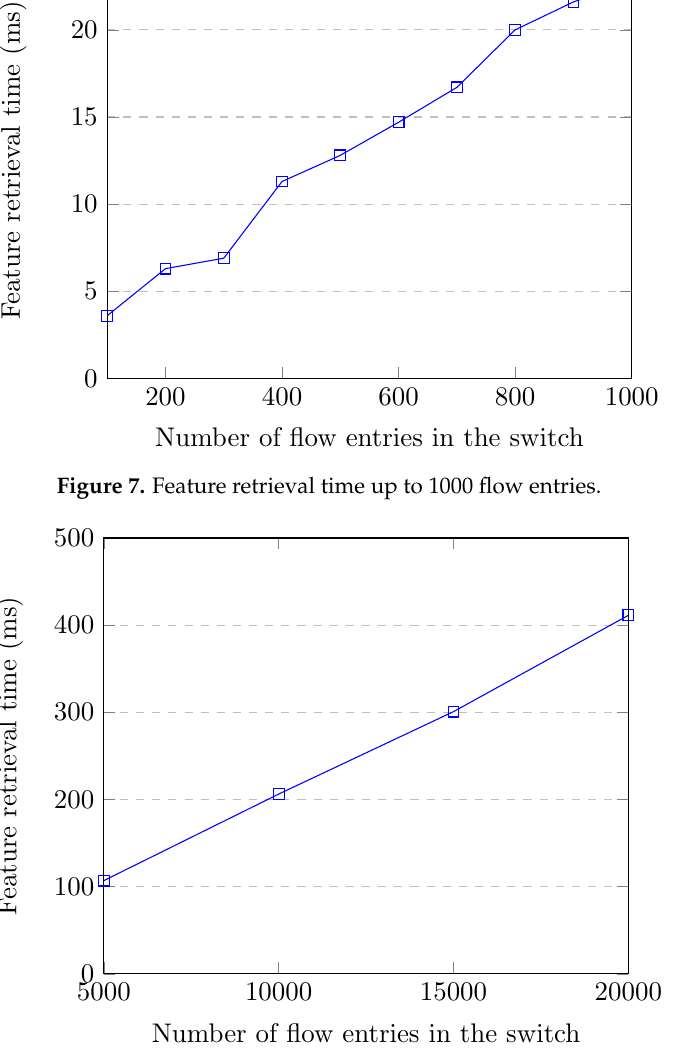
Figure 8. Feature retrieval time up to 20,000 flow